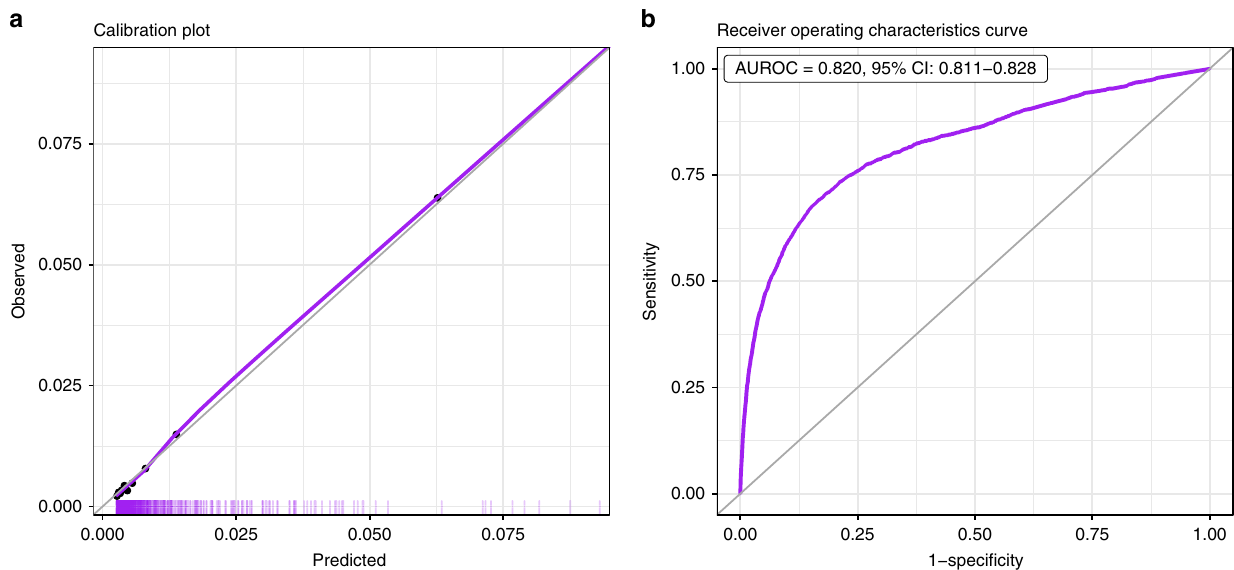
Fig. 2 Performance charts for the baseline model. a Calibration plot, plotting the observed outcome against the predicted probabilities. The diagonal gray line represents perfect calibration. A smoothed line is fi t to the curve, and points are drawn to represent the averages in ten discretized bins. The rug under the plot illustrates the distribution of predictions. b Receiver-operating characteristics curve, plotting the sensitivity against one minus speci fi city for different values of the threshold. The diagonal gray line represents a model with no discrimination. The area under the curve, with its 95% con fi dence interval, is shown on the top-left. Both panels use the test population of the baseline model, n = 315,000 unique patients. AUROC area under the receiver- operating characteristics curve, CI con fi dence